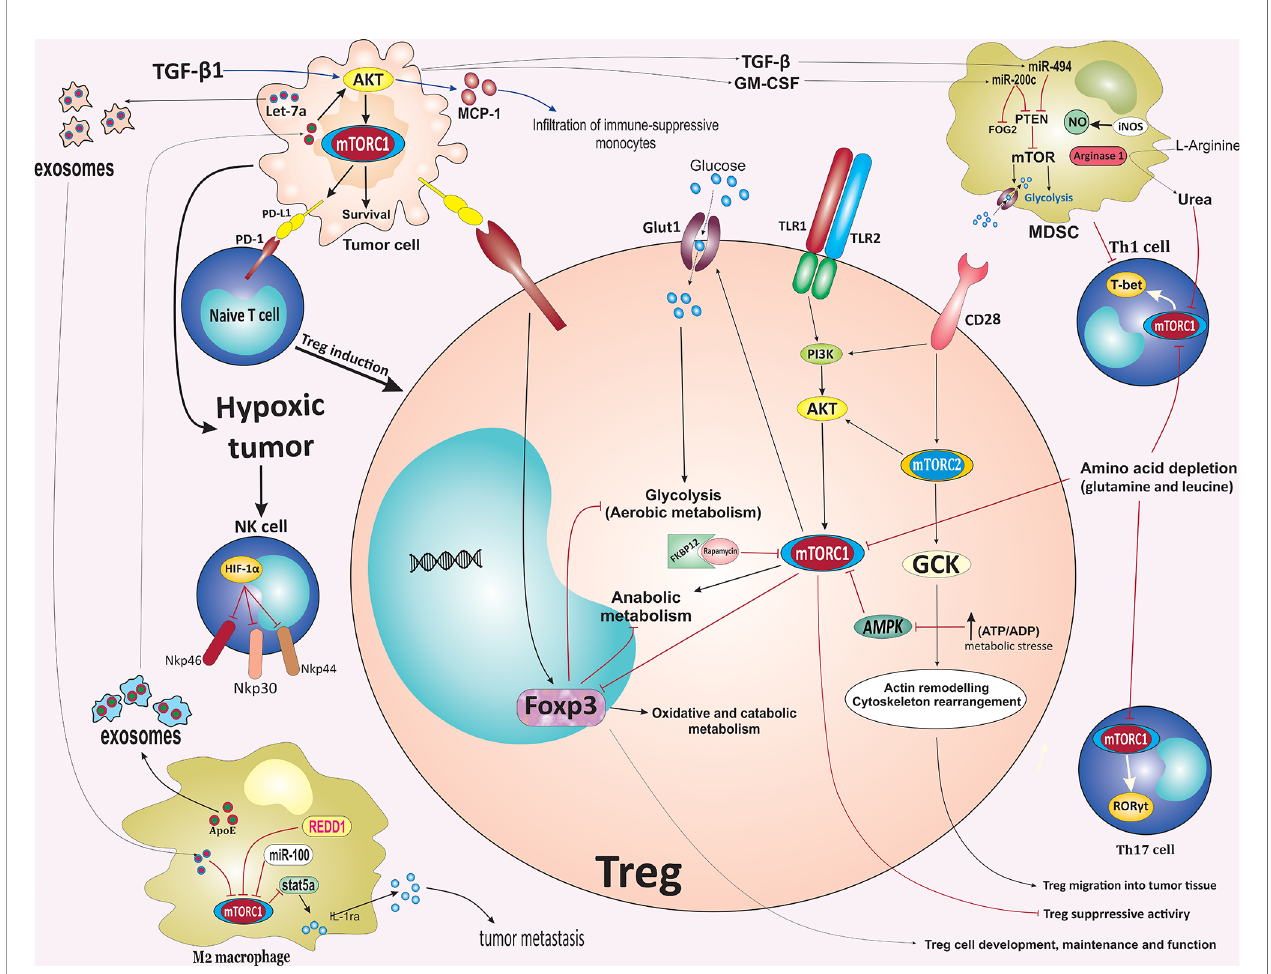
FIGURE 3 | mTOR-mediated regulation of immune cells fate in the tumor microenvironment. Activation of mTORC2 following CD28 stimulation induces GCK expression. GCK promotes the migration of Tregs into tumor tissues via inducing rearrangement of the cytoskeleton. In fl ammatory stimulus and Foxp3 reprogramming Treg cell metabolism by balancing mTORC1 signaling and glucose metabolism to promote the proliferation and suppressive function of Treg cells. TLR-mediated activation of mTOR impairs Treg cells suppressive capacity. In contrast to the mTOR pathway, Foxp3 reduces glucose uptake, glycolysis, and anabolic metabolism while enhancing oxidative and catabolic metabolism. AMPK activation following metabolic stresses such as increases in ATP: ADP ratio during hypoxia suppresses the expression of Glut1 and glycolysis in Tregs by modulating the mTORC1 signaling pathway, which reprograms Treg cell metabolism to promote mitochondrial oxidative metabolism rather than glycolysis. Interaction of PD-L1 on tumor cells with PD-1 on tumor-speci fi c T cells promotes differentiation of naïve CD4 + T cells into Tregs. Downregulation of glutamine and leucine metabolism support Tregs differentiation while repressing the differentiation of Th1 and Th17 effector. In the TME, the upregulation of ARG-1 and iNOS expression in MDSCs results in the depletion of L-Arginine. ARG1-mediated hydrolysis of L-Arginine leads to urea production, which subsequently induces metabolic reprogramming of various cellular components in TME, especially T cells, by suppressing the mTOR signaling pathway. TAMs-derived exosomes enriched ApoE promotes the migration of gastric cancer cells by activating the PI3K/Akt/mTOR signaling pathway. Additionally, PI3K/ Akt/mTOR pathway increases the in fi ltration of immune-suppressive monocytes into tumor sites via inducing the expression of MCP-1 and IL-10, mainly through TGF- b 1. Hypoxia-induced tumor exosomes that contain let-7a miRNA promote OXPHOS activity and downregulate insulin/Akt/mTOR signaling pathway in bone marrow-derived macrophages and promote polarization of in fi ltrating macrophages to an M2-like phenotype. mTOR inhibition suppressed the immunosuppressive function of MDSCs via blocking the iNOS pathway and ARG-1 activity. TAM, tumor microenvironment; GCK, glucokinase; mTOR, mammalian target of rapamycin; TLR, Toll-like receptor; Treg, regulatory T cell; Glut1, glucose transporter 1; ARG1, arginase 1; iNOS, inducible nitric oxide synthase; ApoE, apolipoprotein E; MCP-1, monocyte chemoattractant protein-1; ARG1, arginase 1; MDSC, myeloid- derived suppressor cells; PD-1, Programmed cell death protein 1; OXPHOS, oxidative phosphorylation; REDD1, regulated in development and DNA damage responses 1; TGF- b 1, Transforming growth factor b 1; Foxp3, factor forkhead box protein